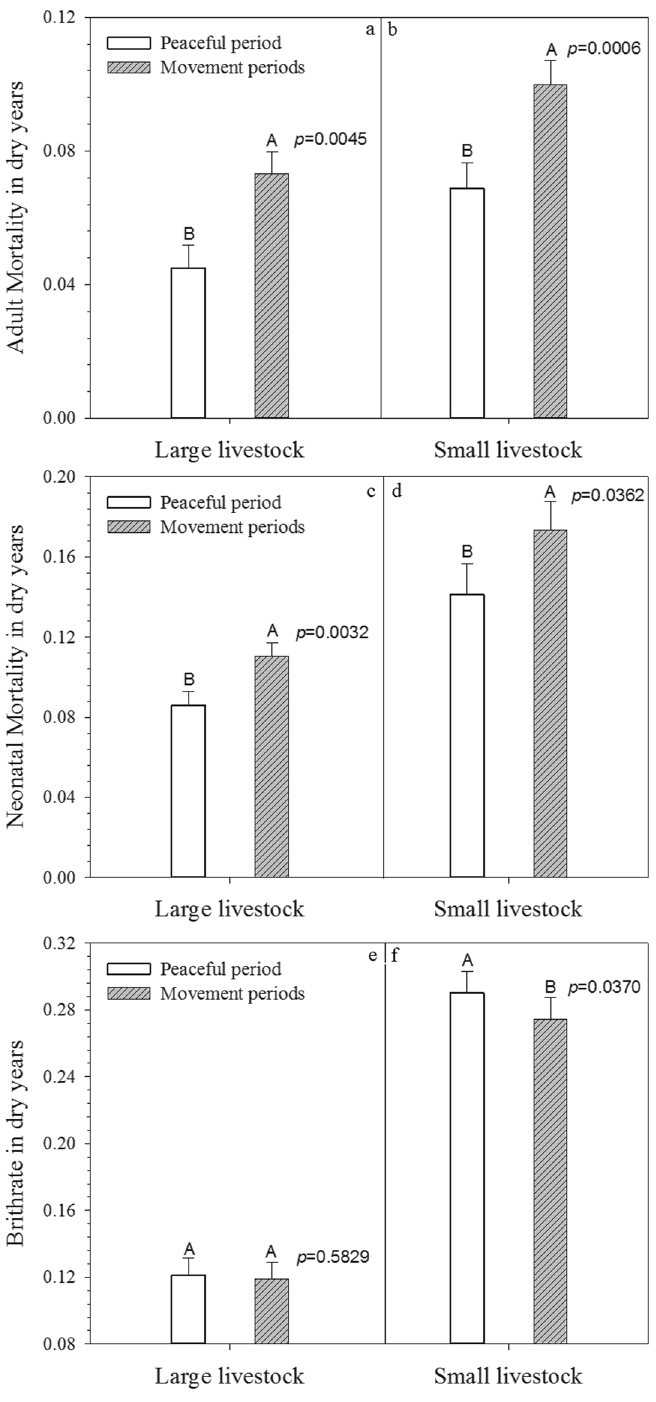
Figure 5. Comparison of Adult, Neonatal Morality and Birthrate in Drought Years during Peaceful and Social Movement Periods. Note: error bars represented standard errors. All population demographic metrics showed significantly differences between peaceful and social movement periods, except birthrate for large